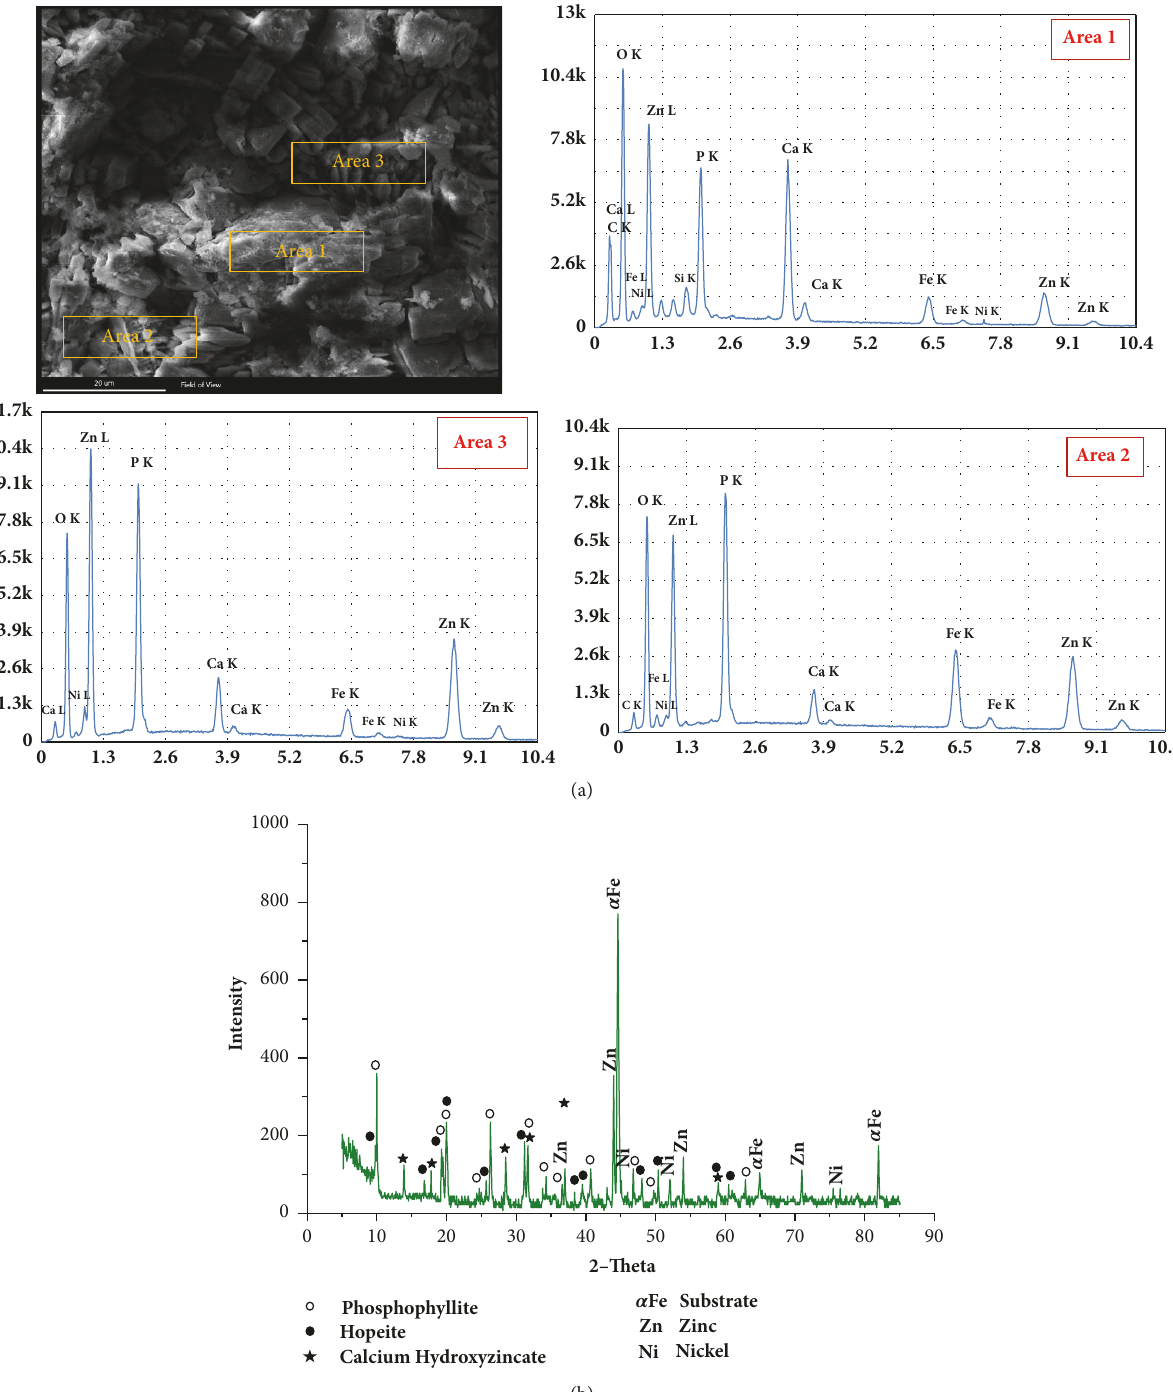
Figure 18: SEMs and EDX (a) and XRD analysis (b) of ZnP-Ni coating after immersion in (CH-Cl) solution for 96